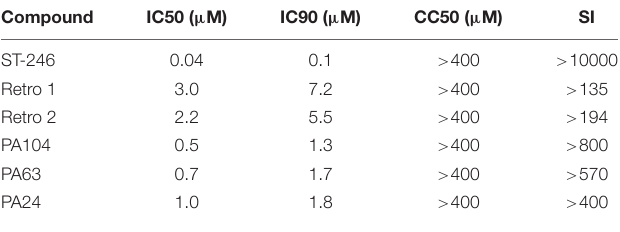
TABLE 1 | Inhibitory and cytotoxic activities of select